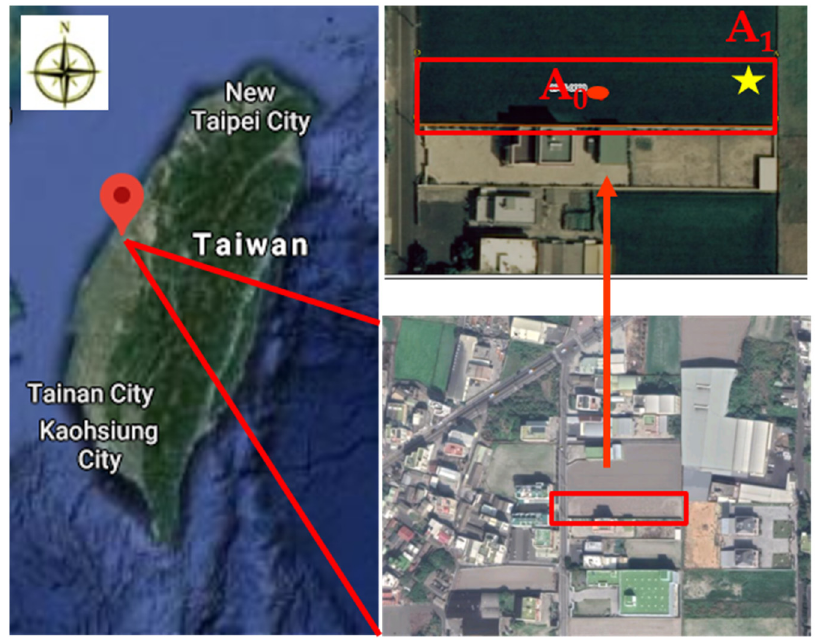
Figure 1. Study area and sampling site in Changhua County (A 0 ; EPA survey site; A 1 ; hot spot/sampling site).